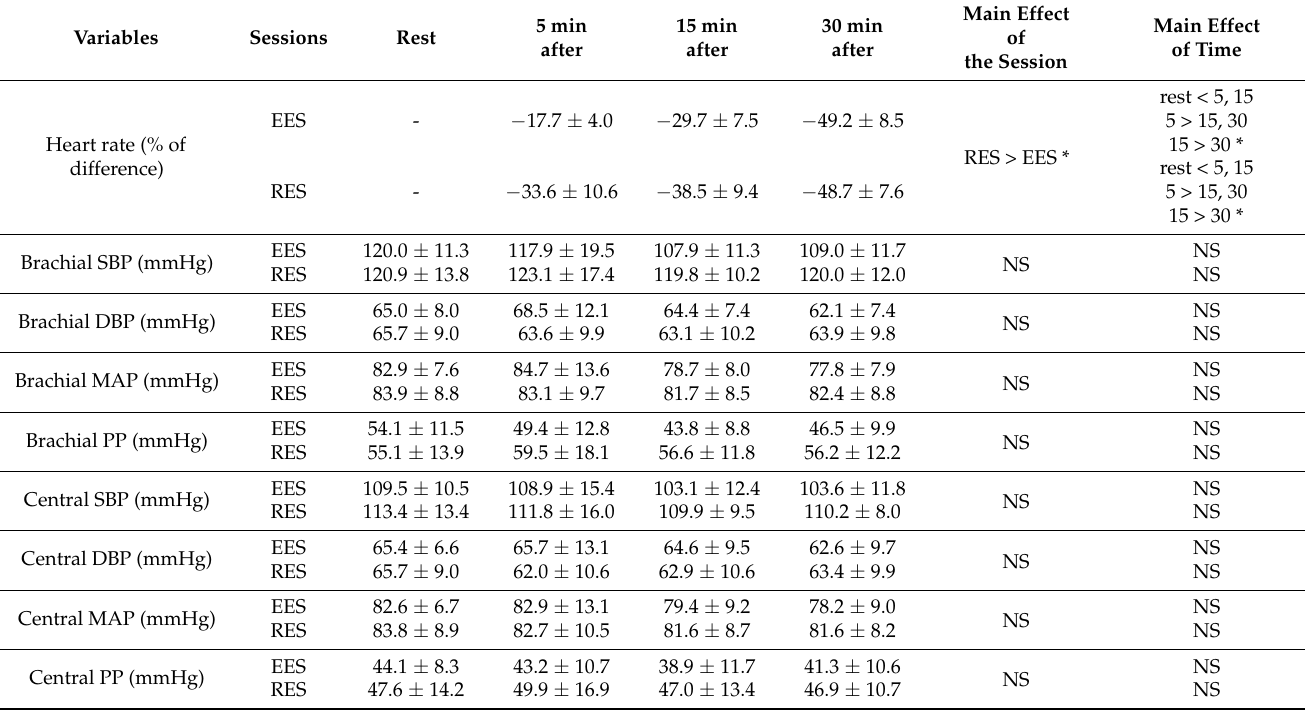
Table 3. Arterial stiffness indices at rest and following endurance and resistance exercise